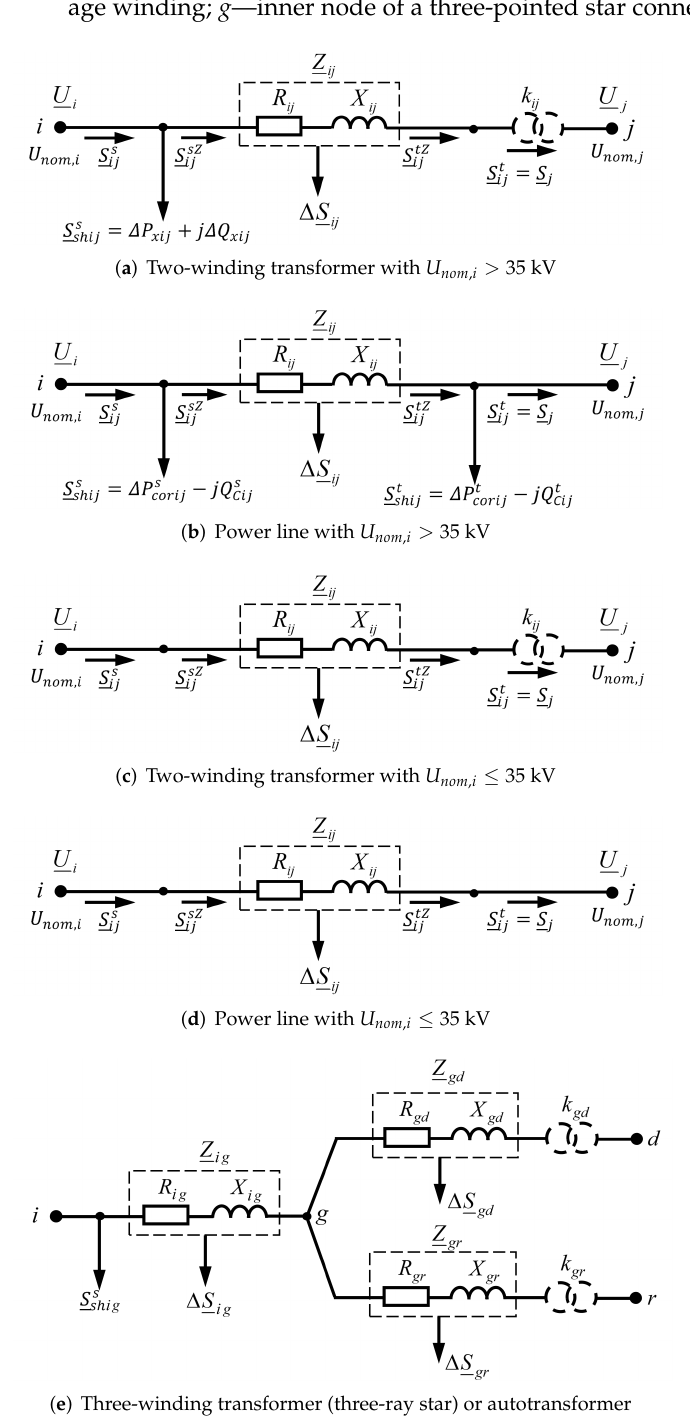
Figure 2. Equivalent circuits of network elements with different nominal